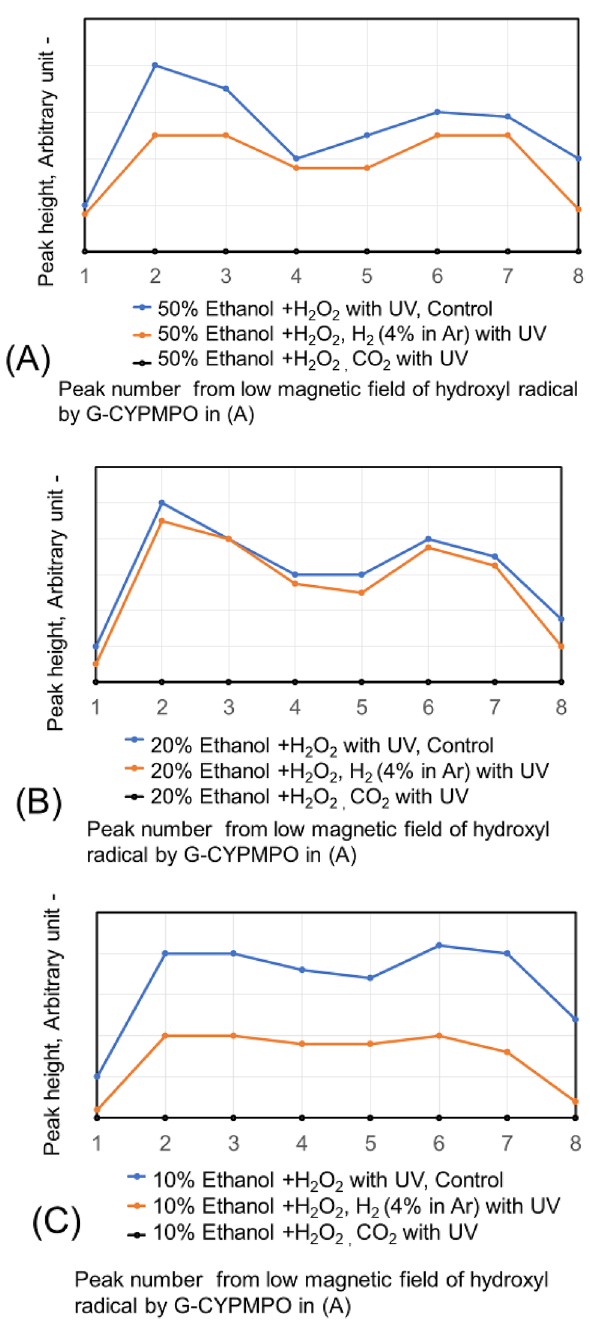
Figure 4. Peaks of hydroxyl radical with ESR by blowing CO 2 and H 2 (4% in Ar) gas nanobubble into 10, 20, and 50% ethanol with 0.1% H 2 O 2 aqueous